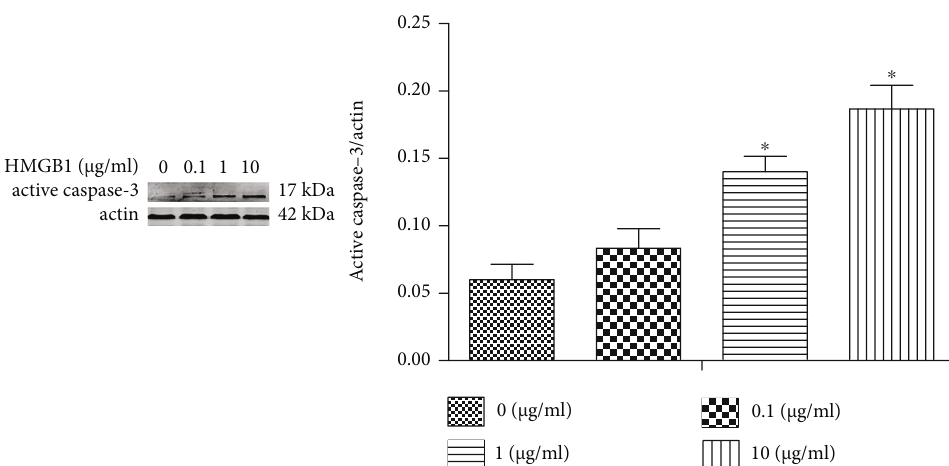
Figure 7: HK-2 apoptosis is increased once exposed to HMGB1. The HK-2 cells were challenged by HMGB1 at various concentrations (0, 0.1, 1, and 10 μ g/mL) for 24 h. Representative Western blotting analysis of active caspase-3 expression in di ff erent groups. ∗ P < 0 : 05 compared with the control